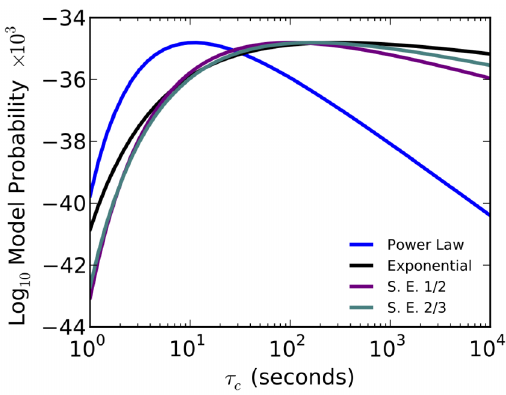
Figure 4. The probability that each of the rate-length laws reproduces the experimentally observed domain size distribu- tion given a value of t c . Given a rate-length law mapping chain length to folding times, if the distribution of sizes of protein domains is modeled as a Gaussian, choosing a timescale t c above which proteins need assistance to fold, and an approximate fraction C of proteins that need assistance to fold fully specifies the distribution of domain sizes (eq. 3; here, C ~ 0 : 10 ). That distribution was used as a model for the generation of the empirically observed domain size distribution reported in Fig. 1,. Here, we plot the probability that the empirically observed distribution resulted from the model indicated. Note the y- axis is log 10 and divided by 10 3 for clarity, so small differences on the plot are actually quite